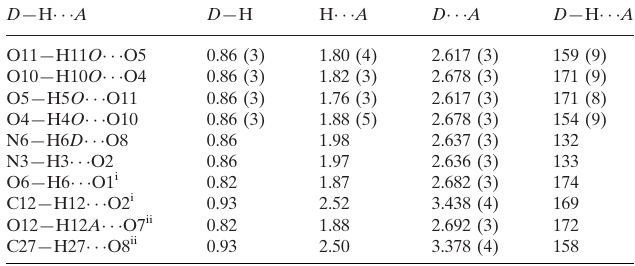
Data collection Bruker SMART CCD area-detector diffractometer 16467 measured reflections